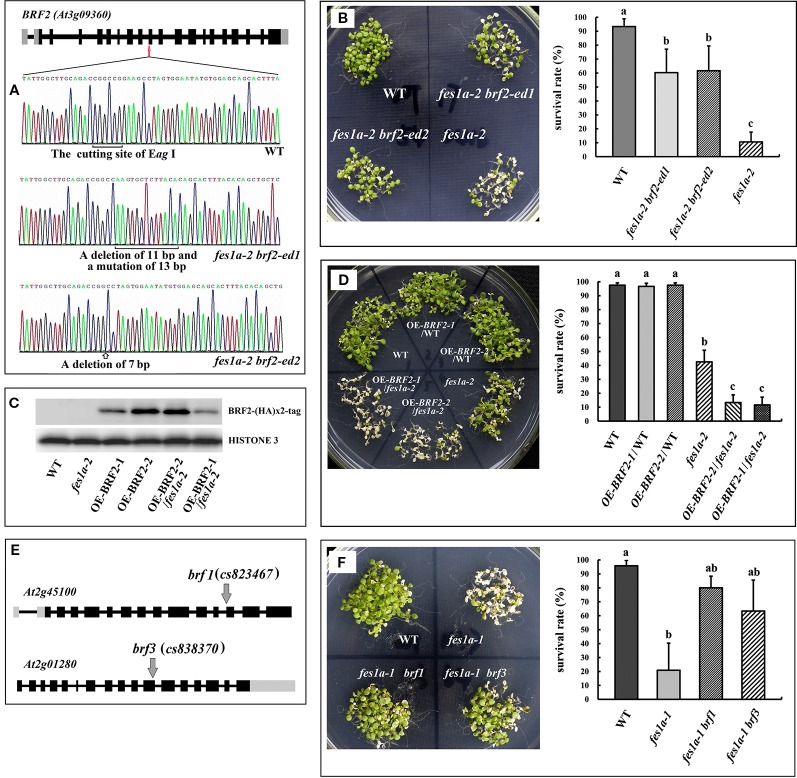

BRF genes suppress the thermosensitivity of fes1a mutants. (A) Sequencing results revealed CRISPR/Cas9 generated mutations (at 10th exon) in the BRF2 gene in fes1a-2 brf2-ed1 and fes1a-2 brf2-ed2 double mutants. (B) The fes1a-2 brf2-ed1 and fes1a-2 brf2-ed2 mutants showing enhanced thermotolerance in comparison with the fes1a-2 mutant (left). The corresponding survival rate is on the right. (C) Western blot result displaying expression of the BRF2-(HA)×2 protein in overexpression transgenic lines. HISTONE 3 was used as a loading control. (D) Overexpression of BRF2 decreased the thermotolerance of the fes1a-2 mutant, but had no effect on wild-type (left). The corresponding survival rate is on the right. (E) A diagram illustrating T-DNA insertions in BRF1 and BRF3 gene. (F) Mutation in BRF1and BRF3 genes improved thermotolerance in the fes1a-1 mutant (left). The corresponding survival rate is on the right. Data in (B, D, F) represent the means of 3 replicates ± SD. For each column, different letters a, b, c indicate significant differences at P < 0.05. The temperature regime of heat stress in (B, D, F) was the same as shown in
Figure 1
, except that the lethal treatment at 45°C lasted for 2 h in (B), 1.5 h in (D), and 2 h in (F).